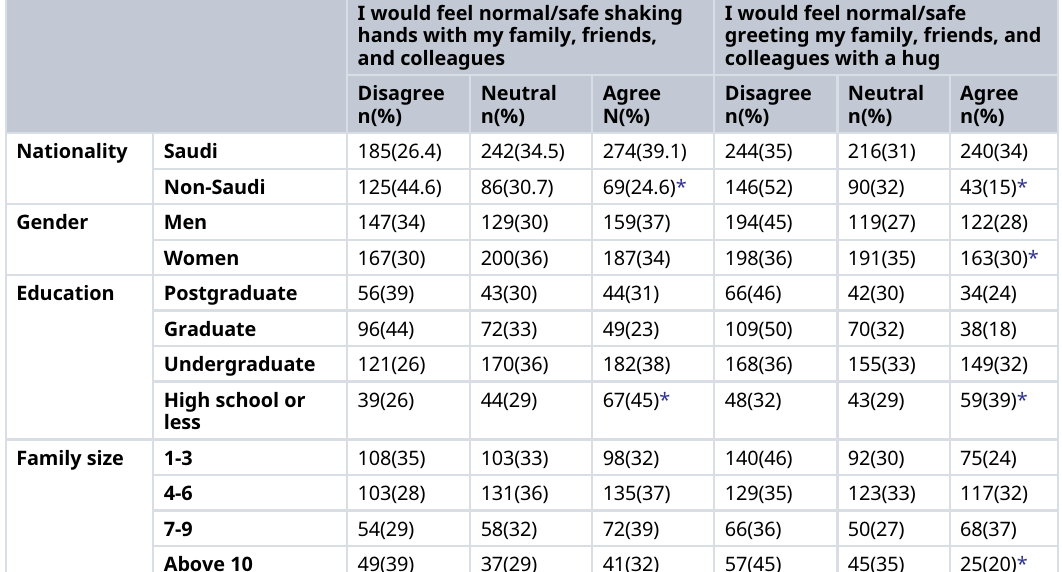
I would feel normal/safe greeting my family, friends, and